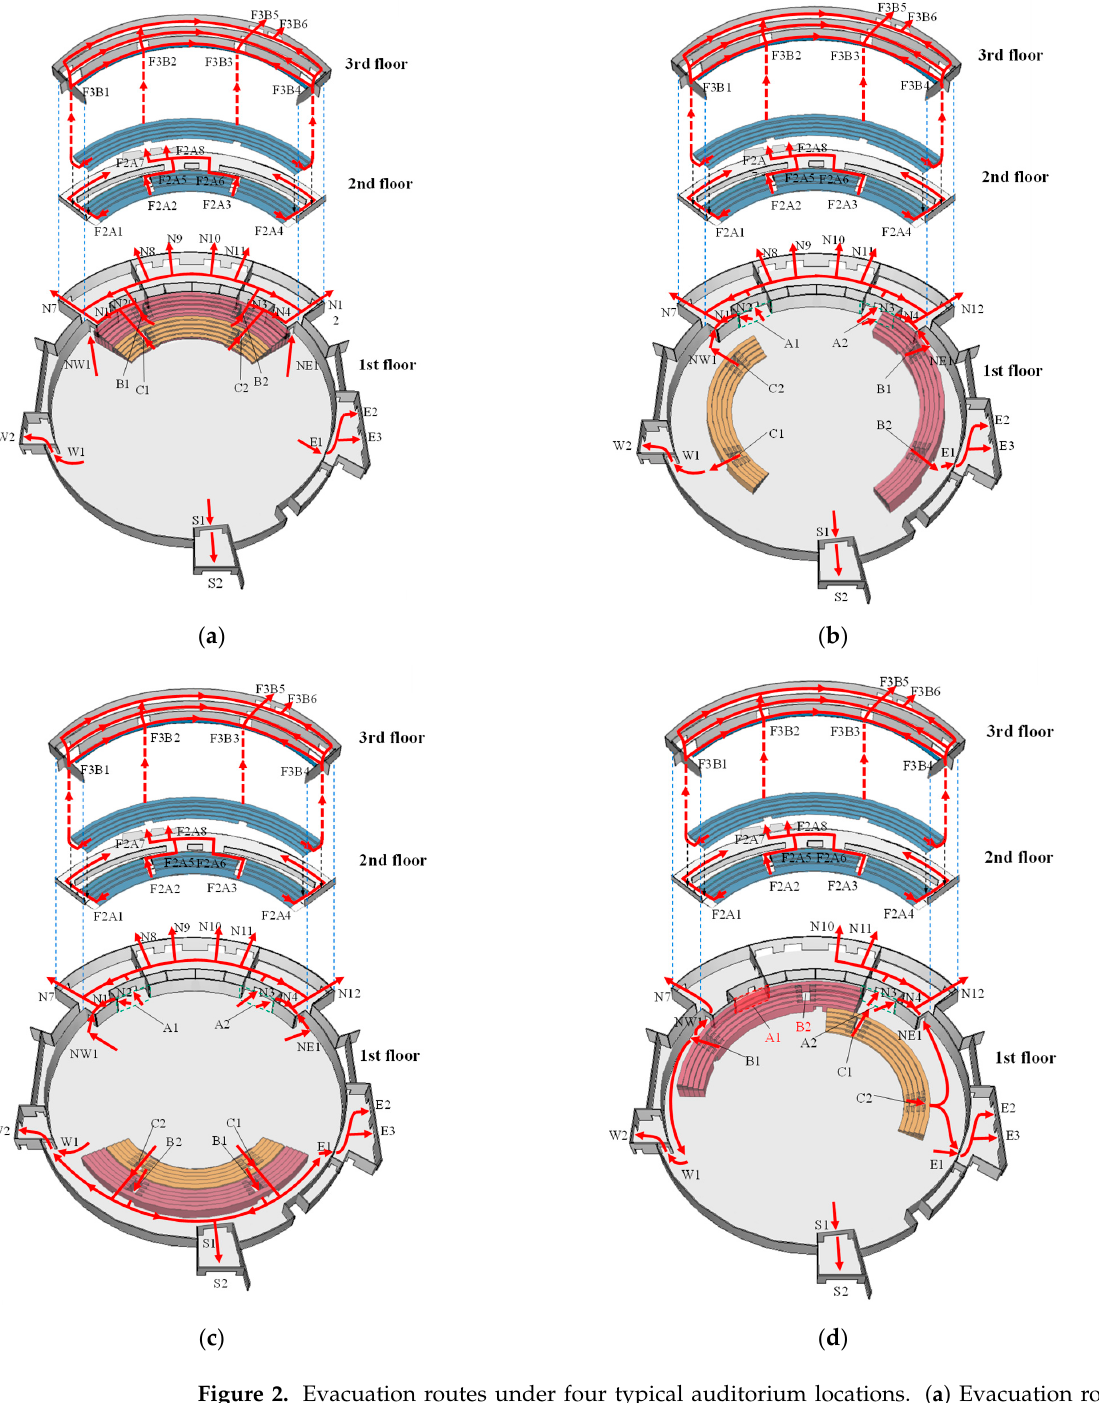
Figure 2. Evacuation routes under four typical auditorium locations. ( a ) Evacuation routes for auditorium location 1; ( b ) evacuation routes for auditorium location 2; ( c ) evacuation routes for auditorium location 3; ( d ) evacuation routes for auditorium location 4. (N1–N12 are the north exits of the 1st floor; S1S2 are the south exits of the 1st floor; E1–E3 are the east exits of the 1st floor; W1–W2 are the west exits of the 1st floor; NE1 is the northeast exit of the 1st floor, and NW1 is the northwest exit of the 1st floor; F2A1–F2A8 are the exits of the 2nd floor; F3B1–F3B6 are exits on the 3rd